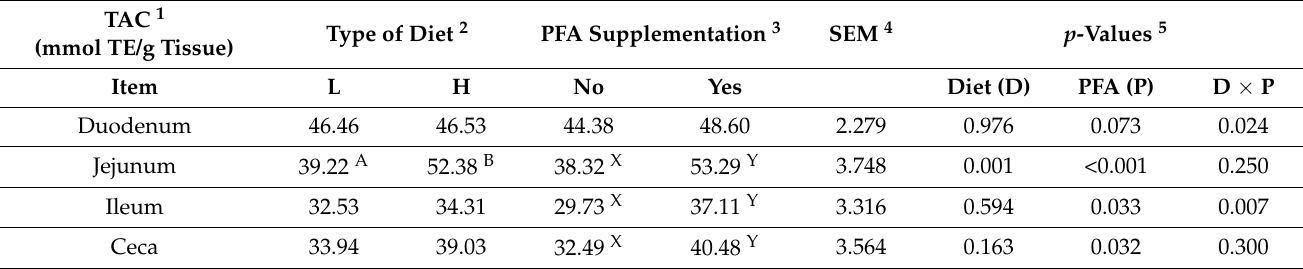
TE = trolox equivalents. 1 Data represent treatment means from n = 9 replicate floor pens per treatment (L, L+, H, H+). 2 Diet type: L (i.e., 95% of recommended ME and CP specs) and H (i.e., 100% of recommended ME and CP specs). Data shown per diet type represent treatment means from n = 18 broilers (e.g., for diet type L, 9 from treatment L − and 9 from treatment L+). 3 Phytogenic feed additive (PFA) supplementation (No = 0 mg/kg diet and Yes = 150 mg/kg diet). Data shown for PFA represent means from n = 18 broilers (e.g., for No PFA supplementation, 9 from treatment L and 9 from treatment H). 4 Pooled standard error of means. 5 Means within the same row with different superscripts per diet type (A, B) and phytogenic feed additives (X, Y) differ significantly ( P <